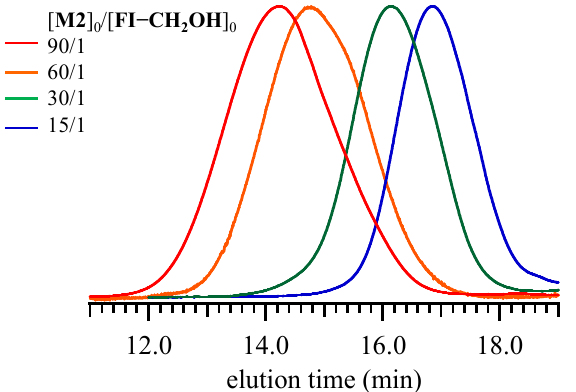
Figure 8. SEC traces of HOCH 2 − 2,7-PCz obtained with different [ M2 ] 0 /[ FI − CH 2 OH ] 0 ratios.